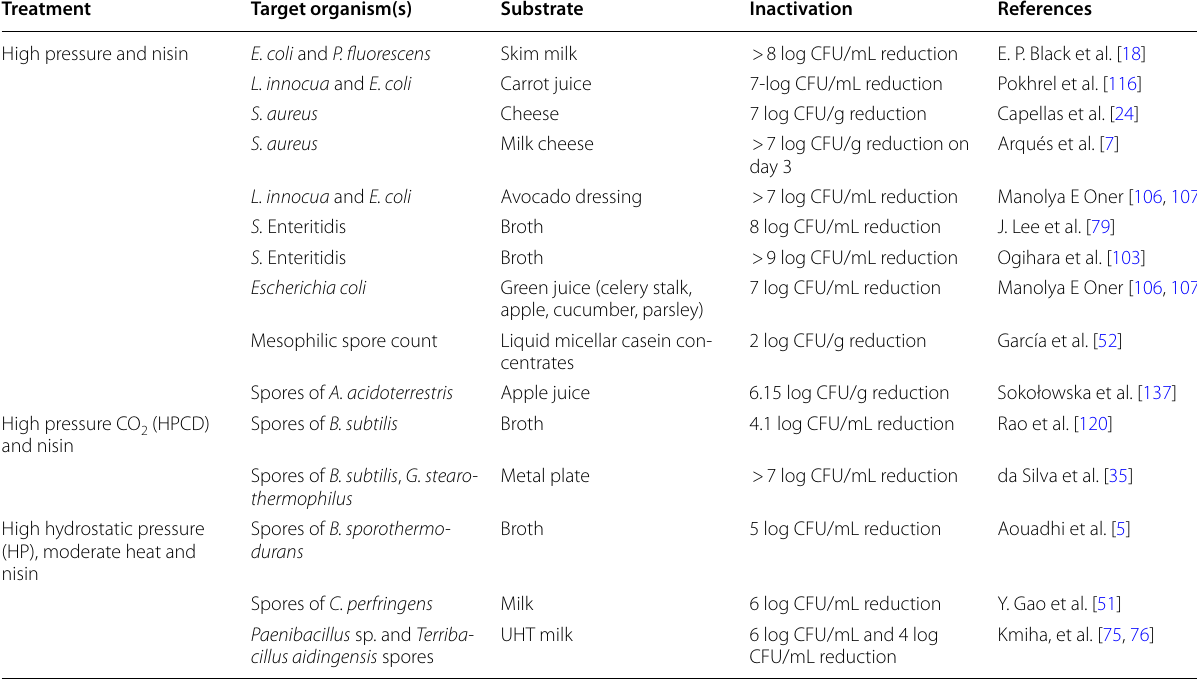
Table 3 Examples of the application of nisin under high-pressure conditions showing increased microbial inactivation